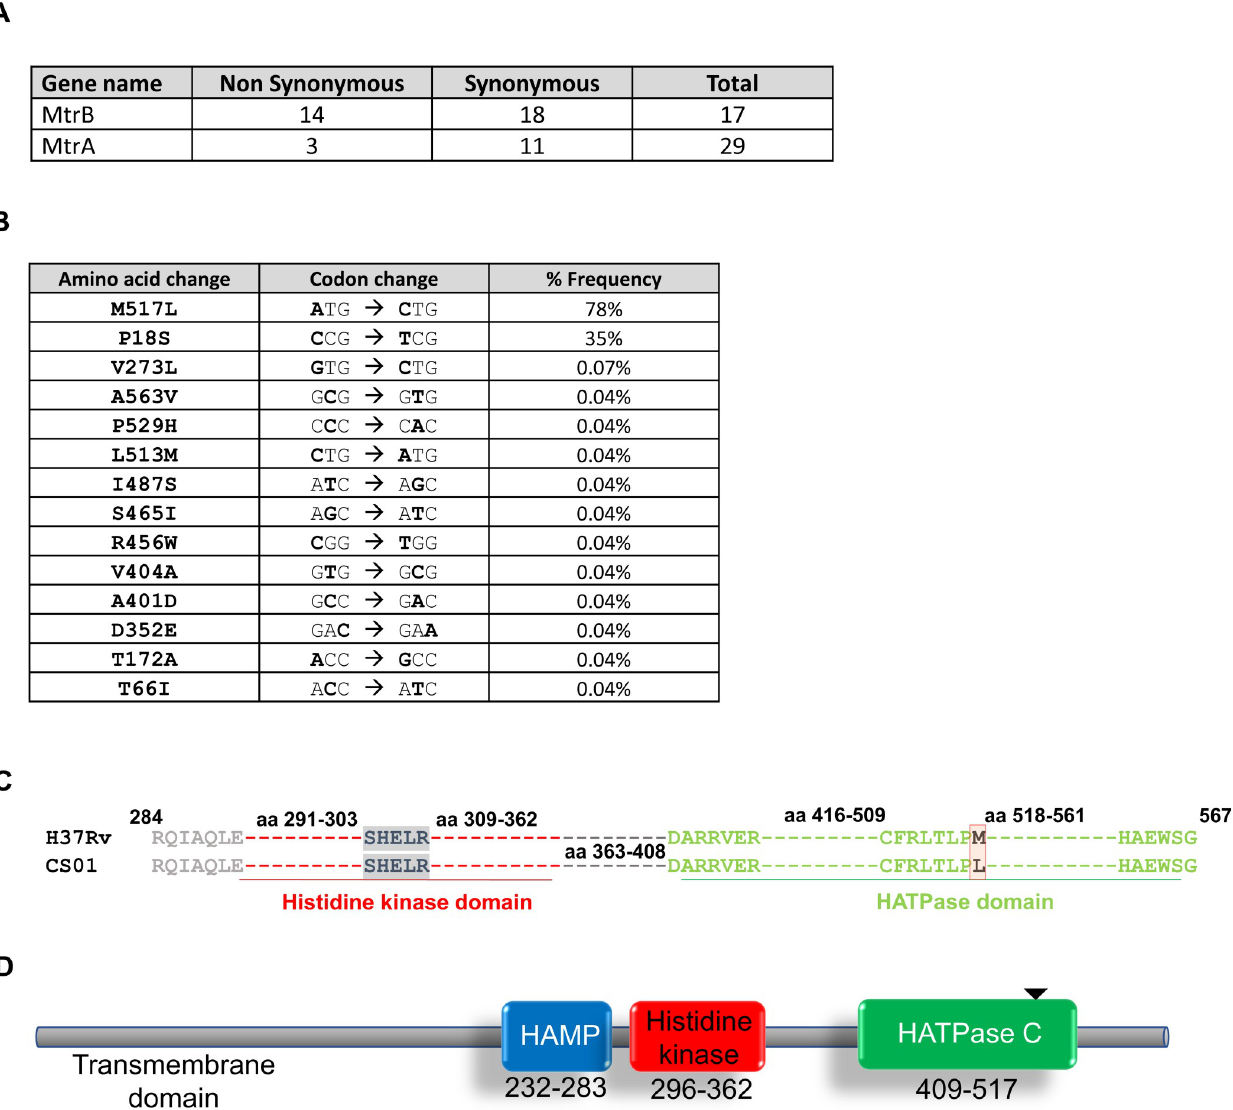
Fig 1. Sequence analysis to identify the SNP in MtrB sensor kinase. A. Total SNPs found in the DNA sequence of the mtrAB TCS in the 2501 strains of M . tuberculosis (sequences available in GMTV database). B. A list of nonsynonymous SNPs found in the MtrB protein with the codon changes and their percentage frequencies. C. Sequence alignment of the protein showing the histidine kinase and HATPase domain of the sensor kinase protein MtrB, using H37Rv as the reference strain. The alignment of sequence from H37Rv and one representative strain from GMTV carrying the mutation is shown. SHELR box in the kinase domain is marked in bold and shaded grey with the mutation from Methionine to Leucine at the 517 th residue marked in bold; CS1 is the number assigned to the representative clinical strain used for alignment. D. Pfam based predicted structure of the sensor kinase protein MtrB, highlighting three distinct domains: the HAMP domain, the Histidine Kinase (HK) domain, and the HATPase domain. The mutation at the 517 th position, which lies in the HATPase domain, is marked by the black arrow.